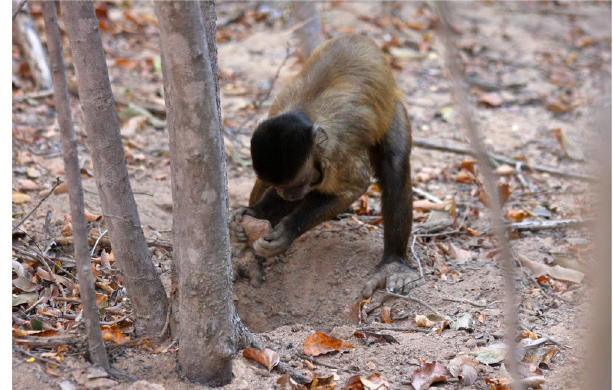
Figure 1. Male capuchin monkey digging with a DST.